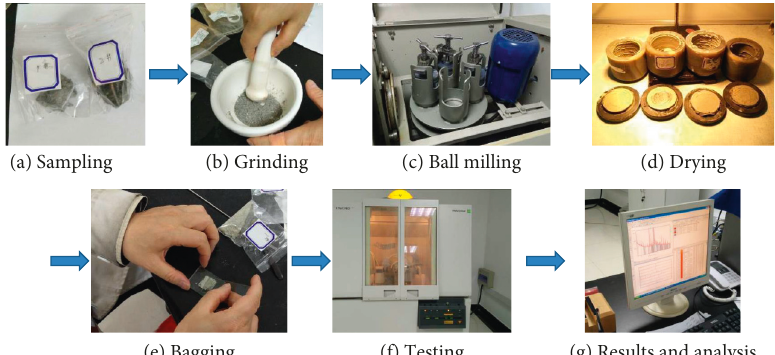
Figure 6: Preparation and procedures of XRD testing. (a) Sampling. (b) Grinding. (c) Ball milling. (d) Drying. (e) Bagging. (f) Testing. (g) Results and